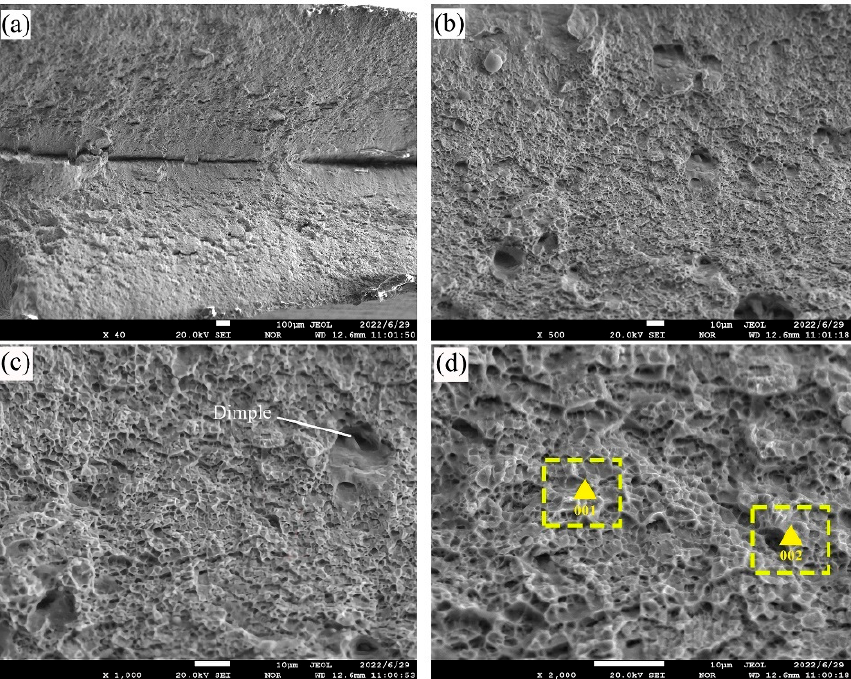
Figure 9. Failure zones of dissimilar welds of 6252/Q550D.